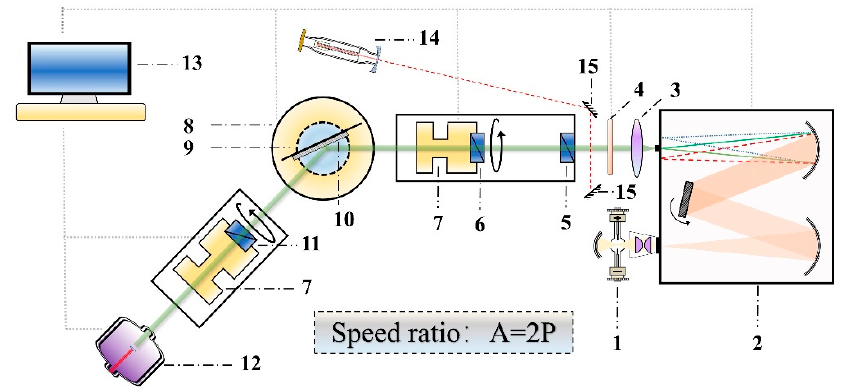
Figure 1. Schematic configuration of the RPAE optical system. (1) The continuous light source; (2) the monochromator consisting of two spherical mirrors and a rotatable plane grating; (3) light- collimating lens; (4) rotatable filters; (5) fixed polarizer; (6) rotating polarizer; (7) stepping motors; (8) rotating stage; (9) sample rotator; (10) sample; (11) rotating analyzer; (12) photomultiplier; (13) computer to control the monochromator, stepping motors, filters, rotating table, sample stage, and the photomultiplier; (14) laser used for alignment; and (15) mirrors to guide the laser beam for alignment.